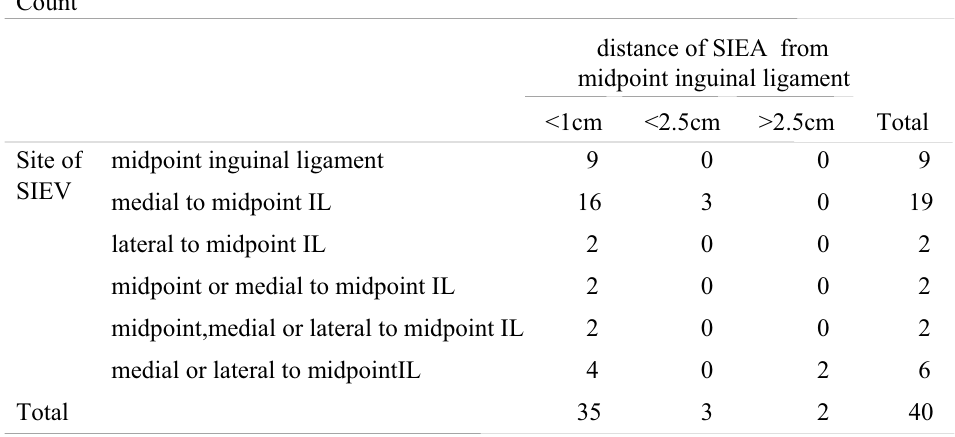
TABLE 2 - Site of identification of SIEV at inguinal ligament